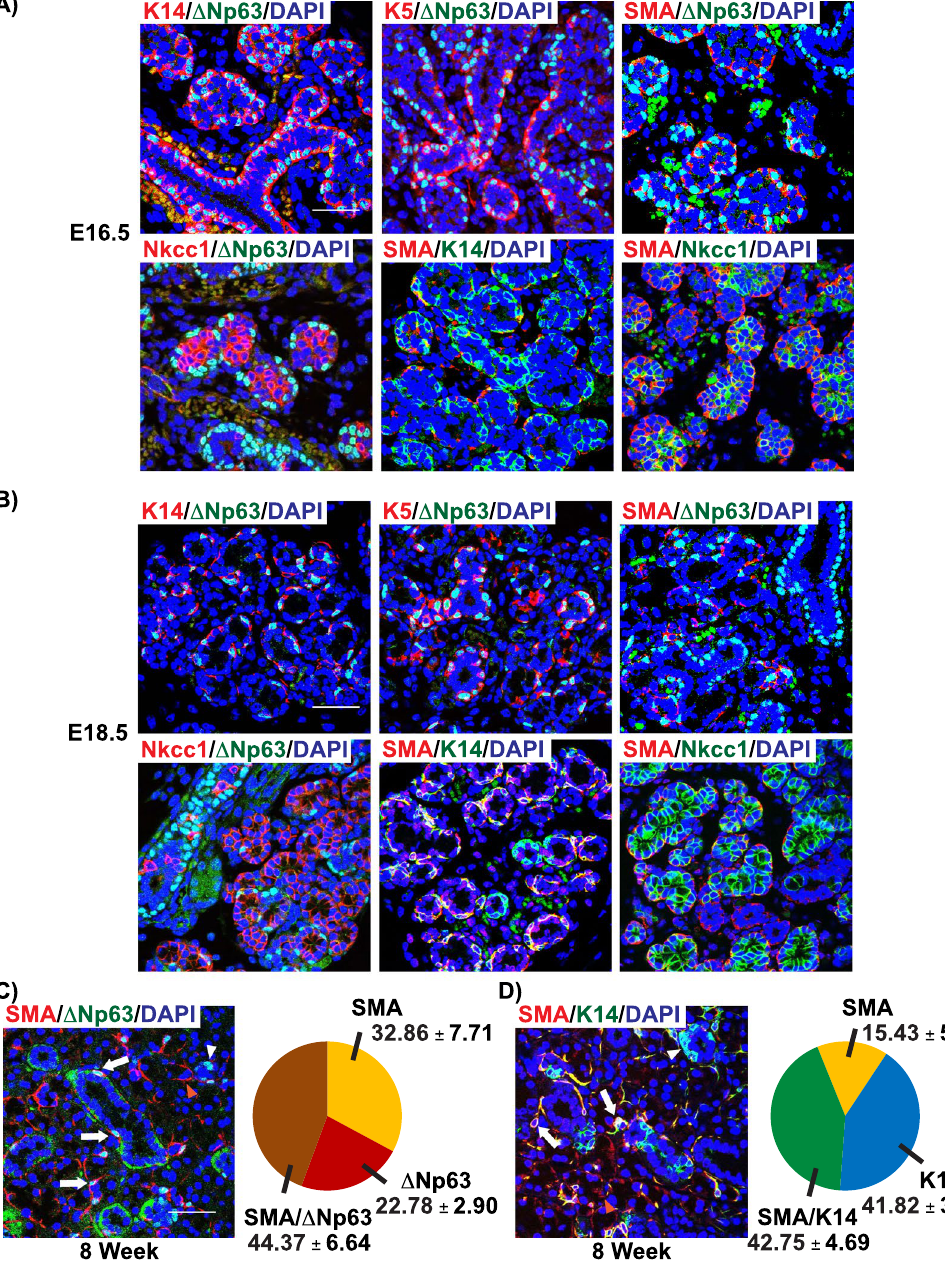
Figure 3. Expression pattern of Δ Np63 and SMA during the later stages of salivary gland development and adults. ( A , B ) Expression of Δ Np63 and SMA at E16.5 and E18.5. ( C ) Expression and quantification analyses of SMA and Δ Np63 in 8-week old adult glands. Arrow- SMA + / ∆ Np63 + cells, white arrowhead- SMA − / ∆ Np63 + cells, orange arrowhead-SMA + / ∆ Np63 − cells. ( D ) Expression and quantification analyses of SMA and K14 in 8-week old adult glands. Arrow- SMA + /K14 + cells, white arrowhead- SMA − /K14 + cells, orange arrowhead- SMA + /K14 − cells. Data are represented as mean ± standard deviation (S.D.). Scale bar 37 μ m. n = 3